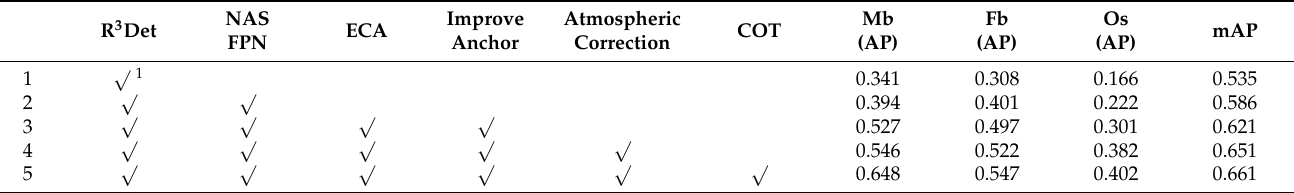
Figure 14. Display of test results before and after model improvement—inaccurate positioning improvement. Table 3. Test results of improved ablation experiments.